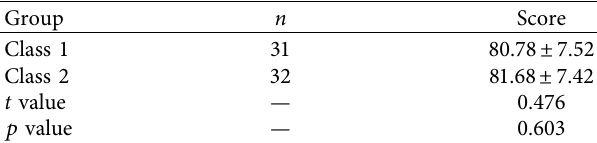
Table 3: Comparison of the theoretical examination results of surgery courses between two classes of